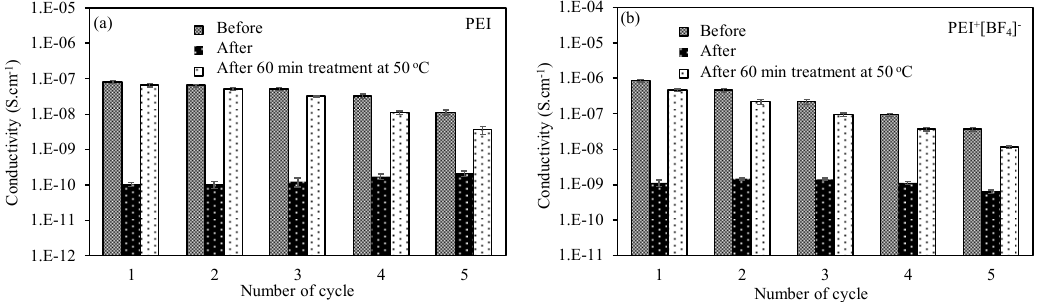
Figure 7. The percent recovery studies of ( a ) bare PEI cryogel and ( b ) PEI + [BF 4 ] − cryogel under 240 min CO 2 gas exposure [200 mL/min flow rate].